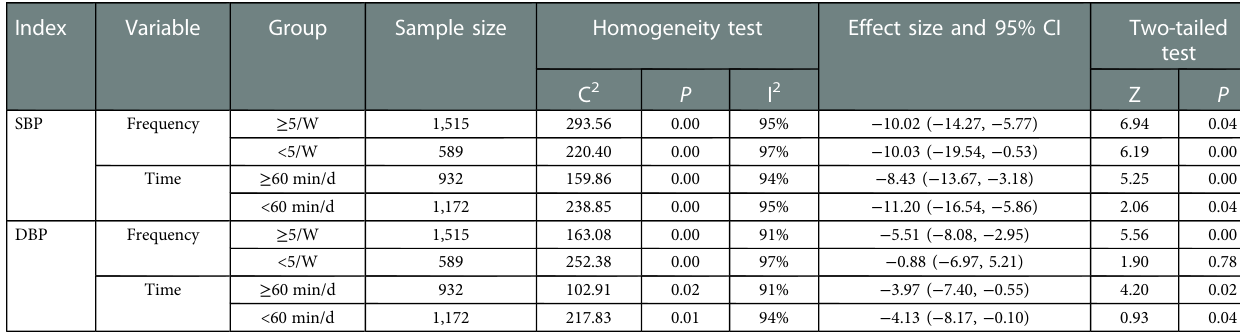
TABLE 2 The subgroup analysis of blood pressure.